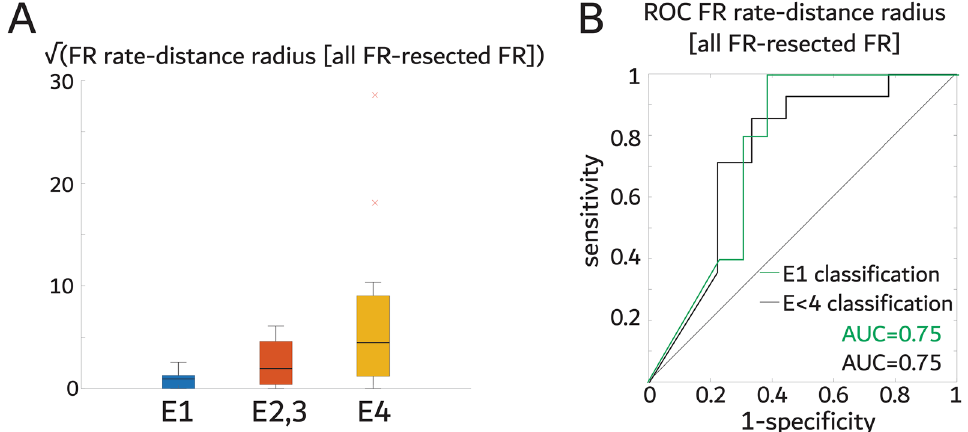
Figure 3. The spatial FR graph theoretical measure the FR rate-distance radius difference between all FR generating contacts minus FR generating contacts in resected regions distinguishes seizure free patients (E1) and seizure improved patients (E1-3). ( A ) Box plot of the square root of the difference of the FR rate-distance radius between all FR generating contacts and only resected FR generating contacts stratified by Engel class (E). The square root is used for visualization purposes only (raw values, spearman rank correlation p < 0.05). ( B ) Receiver operating characteristic curve (ROC) of the raw difference of the FR rate-distance radius difference between all the FR generating contacts and the FR generating contacts in the resected regions for classifying seizure free patients, and improved